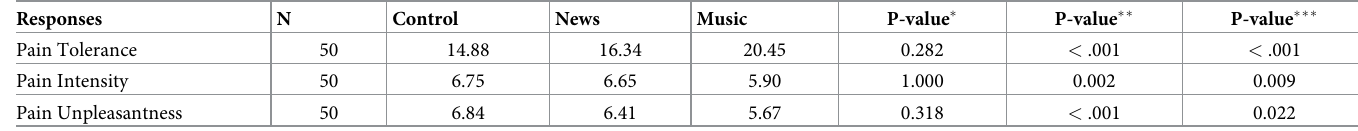
Table 3. Pairwise tests for comparing between treatments for each pain variable. Responses